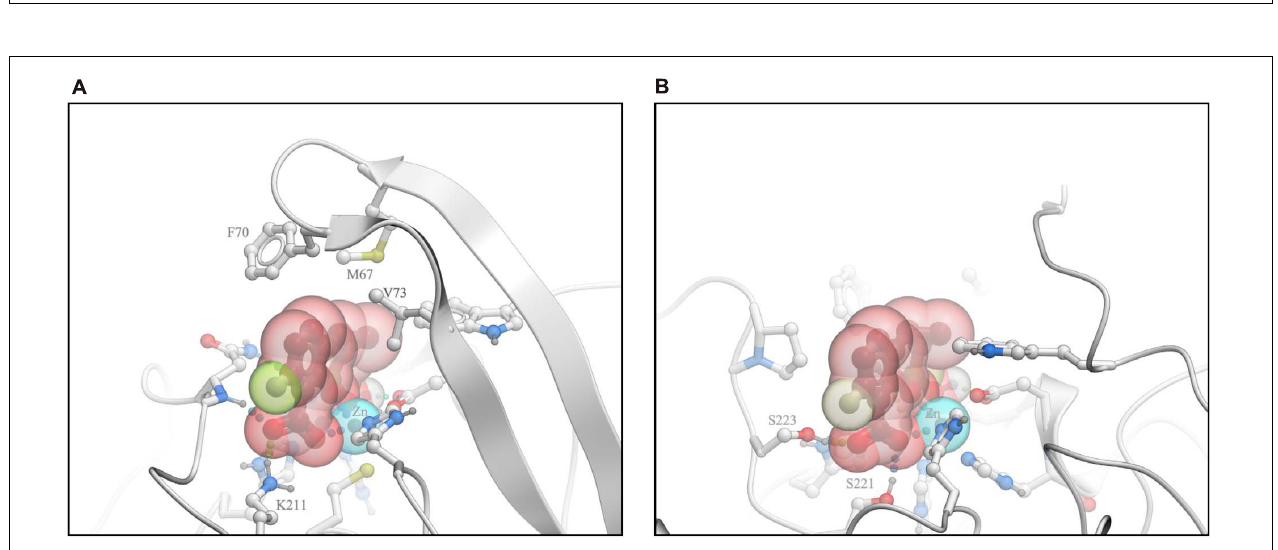
FIGURE 4 | (A) Comparison of QPX7728 and vaborbactam in complex with KPC-2 with carbon atoms of QPX7728 and vaborbactam in light brown and in yellow carbon atoms, respectively [accession codes are the following: 6V1J (KPC-2:QPX7728); 6TD0 (KPC-2:vaborbactam)]. (B) Superposition of QPX7728 (crème carbon atoms) and the core ring system of penem antibiotics (magenta carbon atoms).